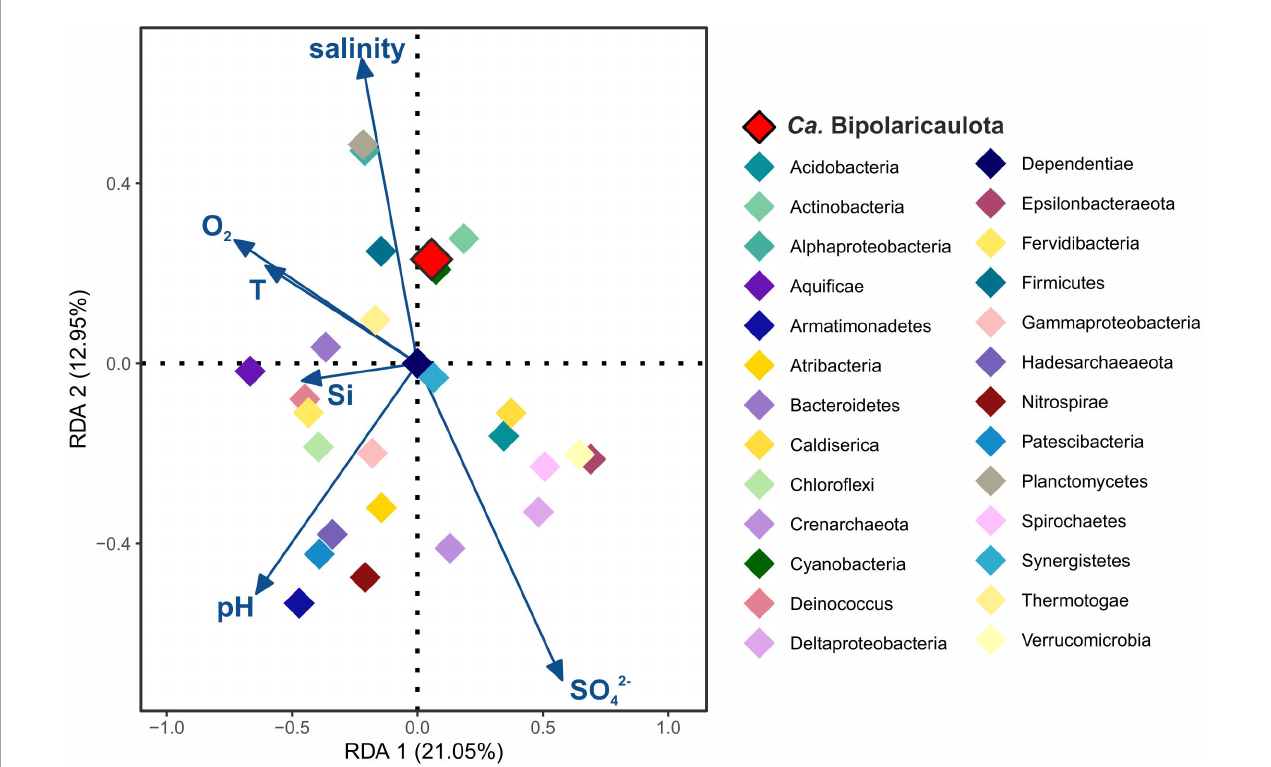
FIGURE2 Redundancy analysis (RDA) ordination plot for Biga Peninsula Phylum operational taxonomic units (OTUs) distribution constrained by six environmental variables. Environmental parameters (blue arrows) included: oxygen concentration (O 2 ), temperature (T), pH, salinity, silica (Si), and sulfate (SO 42 - ) concentration. Color codes of the different phylum are the same as in Figure 1 , being “ Ca. Bipolaricaulota” highlighted in